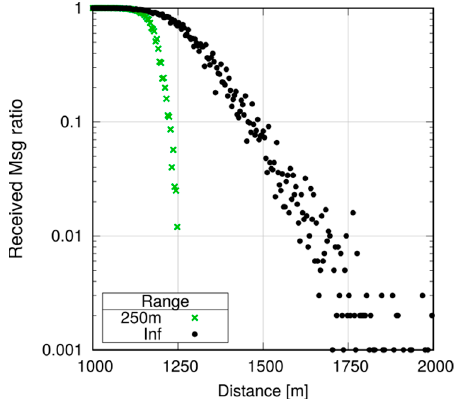
Figure 27. Reception probability in the multihop case, h = 250 m.